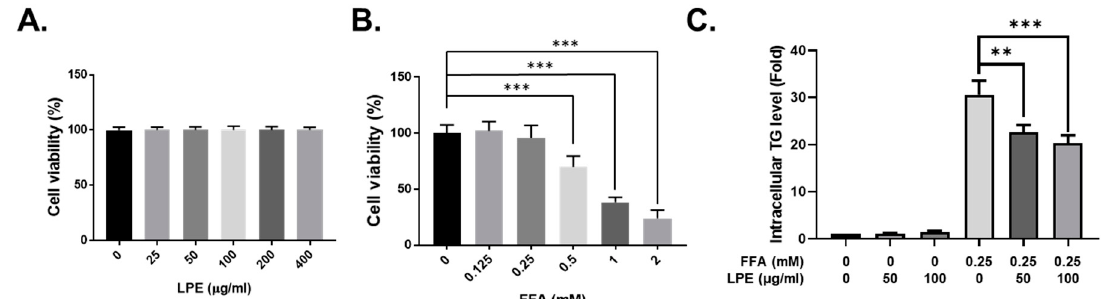
Figure 5. LPE treatment decreased TG accumulation in FFA-treated HepG2 cells. ( A ) Effects of LPE on cell viability in HepG2 cells. HepG2 cells were incubated with various concentrations of LPE for 24 h and the cell viability was measured using a CCK-8 assay kit. ( B ) Effects of FFA on HepG2 cell viability. HepG2 cells were incubated with various concentrations of FFA for 24 h and the cell viability was measured using a CCK-8 assay kit. ( C ) Effect of LPE on FFA-induced TG accumulation in HepG2 cells. HepG2 cells were incubated with or without 0.25 mM of FFA and 50 or 100 μ g/mL of LPE for 24 h. The TG was measured using a TG assay kit. Data are shown as mean ± SEM, n = 3, ** p < 0.01 or *** p < 0.001. One-way ANOVA was performed along with Fisher’s protected least significant difference test.